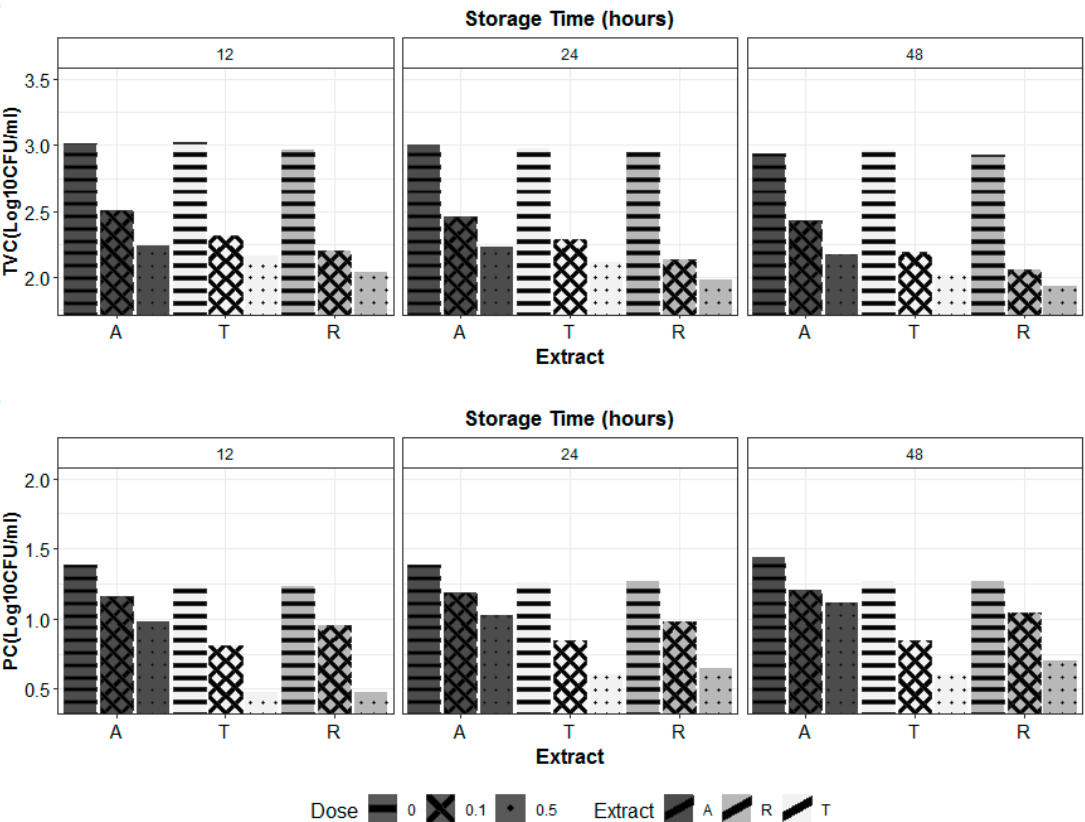
Figure 2. Total viable count (TVC, ( A )) and psychrotrophic bacteria count (PC, ( B )) of cold-stored (6 °C) pasteurized milk samples supplemented with thyme, rosemary, and ammoides aqueous extracts at different levels (0, 0.1, and 0.5 mg/mL). A, ammoides; R, rosemary; T, thyme. The microbial load in pasteurized milk may be attributed to the growth of heat-re- sistant bacteria that are able to withstand the temperature of pasteurization [24].